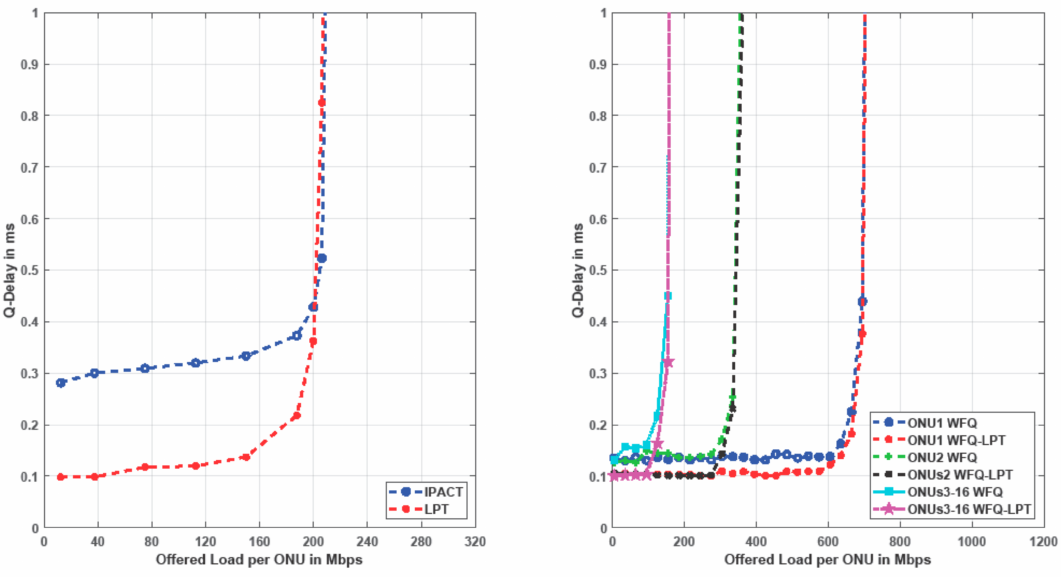
Figure 7. Queue delay for all ONUs at LTT = 0 µ s; IPACT vs. LPT ( left ) and WFQ vs. WFQLPT ( right